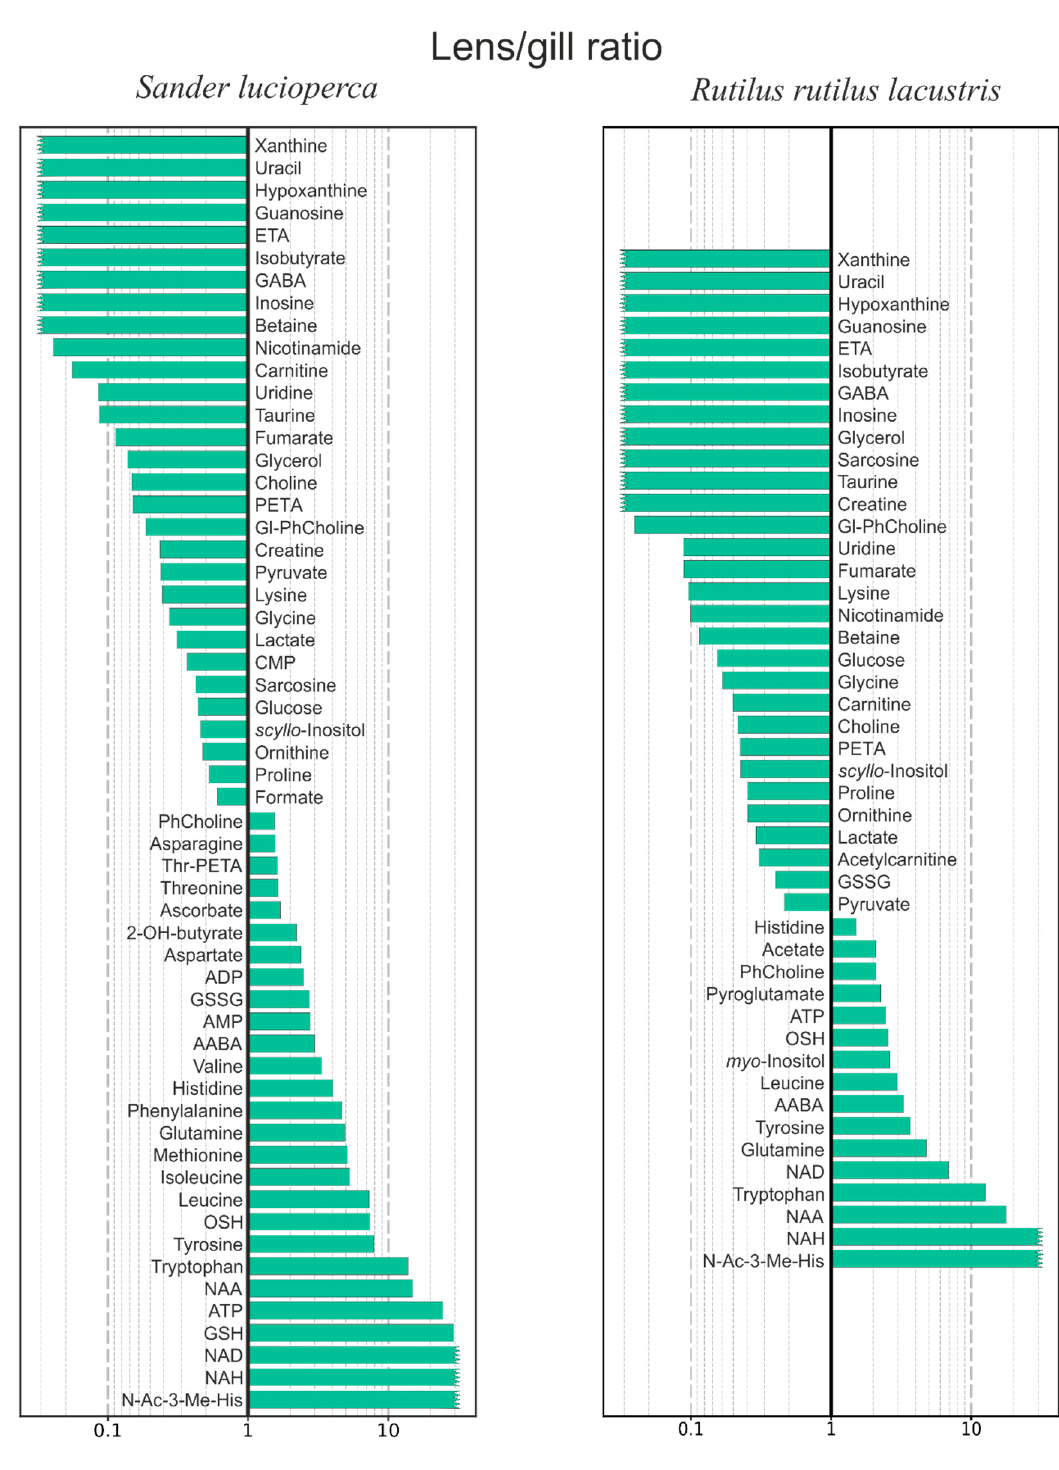
Figure 5. Barplots for statistically significant di ff erences ( p < 0.05) in the metabolomic content of lenses and gills. Bars show the ratio of metabolite concentrations in lenses to that in gills for S. lucioperca ( left ) and R. rutilus lacustris ( right ) in logarithmic scale. Jagged bar ends indicate ratios > 30 and < 0.03. The metabolites with insignificant di ff erence (fold change below 1.5, p > 0.05) between lens and gill are not shown. The bars expanding to the left from the unity correspond to the elevated level of a metabolite in the gill, and to the right, to the elevated level in the lens.